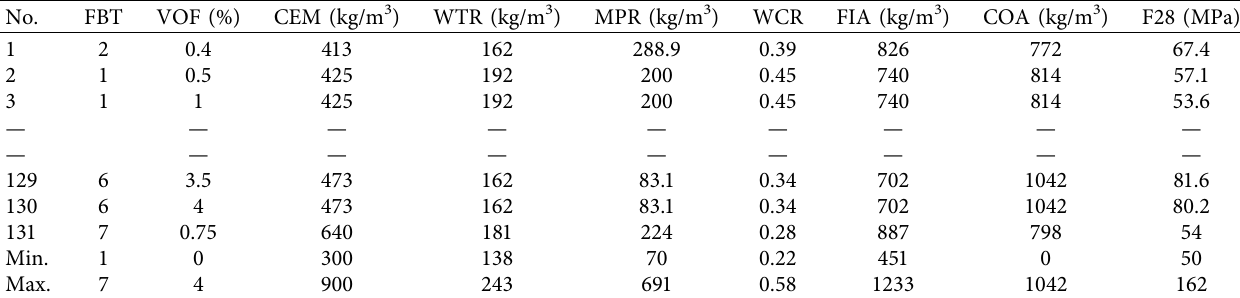
Table 1: Characteristics of input and output.